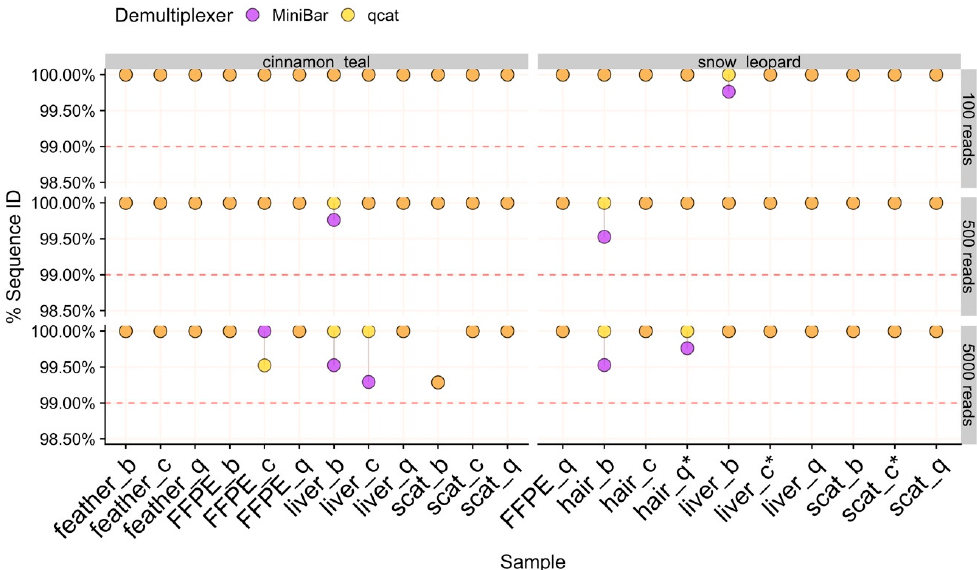
Figure 4. The percent sequence similarity of MinION consensus to Sanger sequence from Blast for 100R, 500R, and 5KR subsets for each species. Samples are labeled by tissue type and extraction method (b = biomeme, c = chelex, q = qiagen). Points are linked by a grey line to show difference in values from demultiplexers. Overlapping areas in orange indicate similar results for Minibar and qcat analyses. The horizontal dashed line is the 99% threshold for sequence similarity. Asterisks (*) indicate samples with cinnamon teal read contamination.